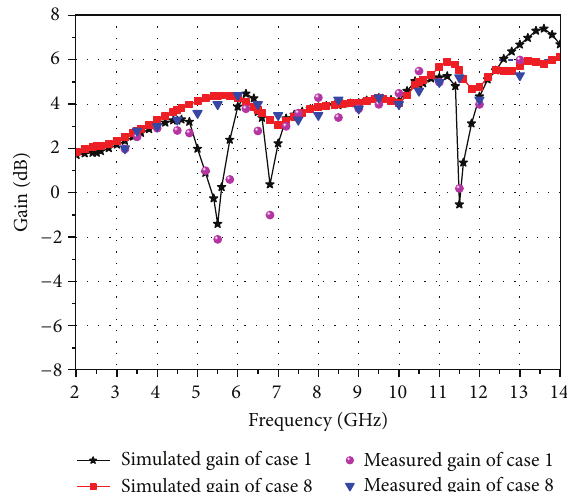
Figure 17: Gains of fabricated CRA C in case 1 and case